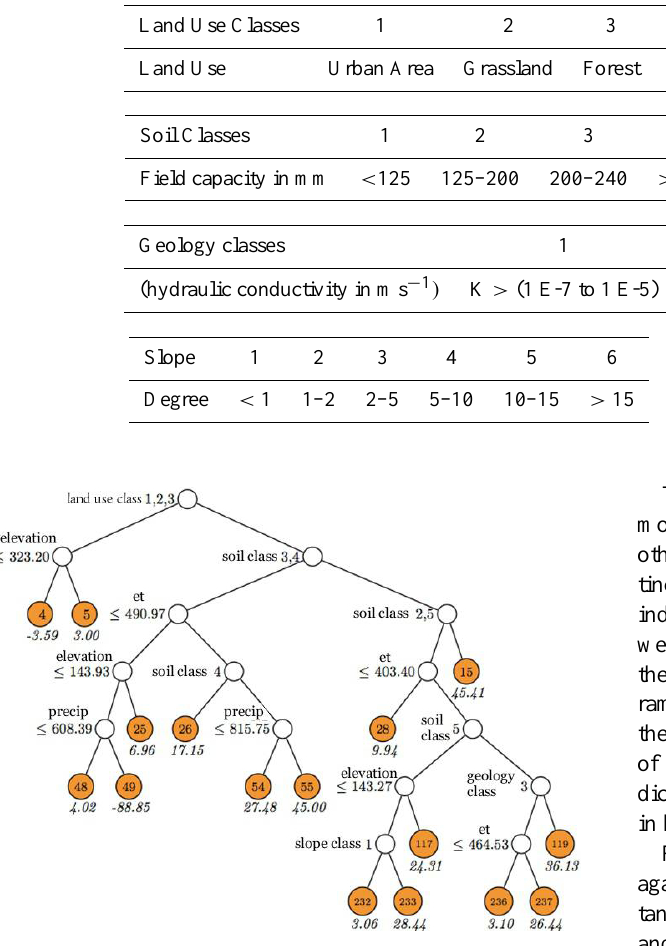
Fig. 6. Regression tree to predict the average excess nitrogen in kgha − 1 a − 1 for the landscape type Arable Hill